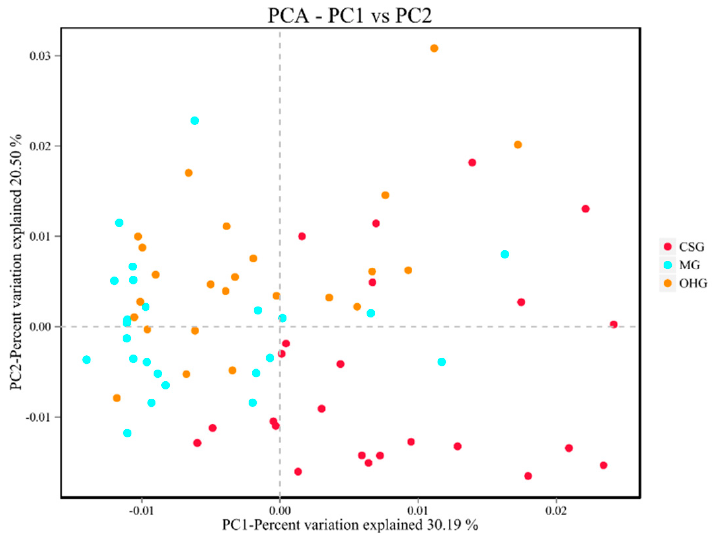
Figure 5. The e ff ect of oat hay on the beta diversity of rumen microbes in Figure 5. The effect of oat hay on the beta diversity of rumen microbes in sheep.